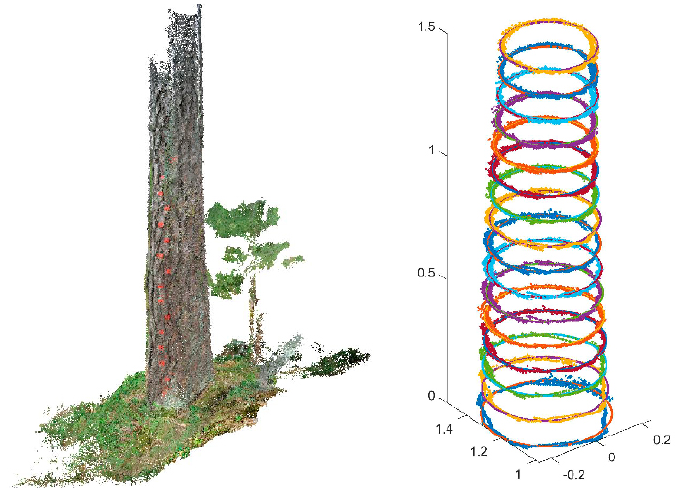
Figure 4. ( Left ) A reconstructed point cloud of a tree stem and surroundings obtained with mobile device. ( Right ) Extracted cross-sections of stem applied in circle fitting.